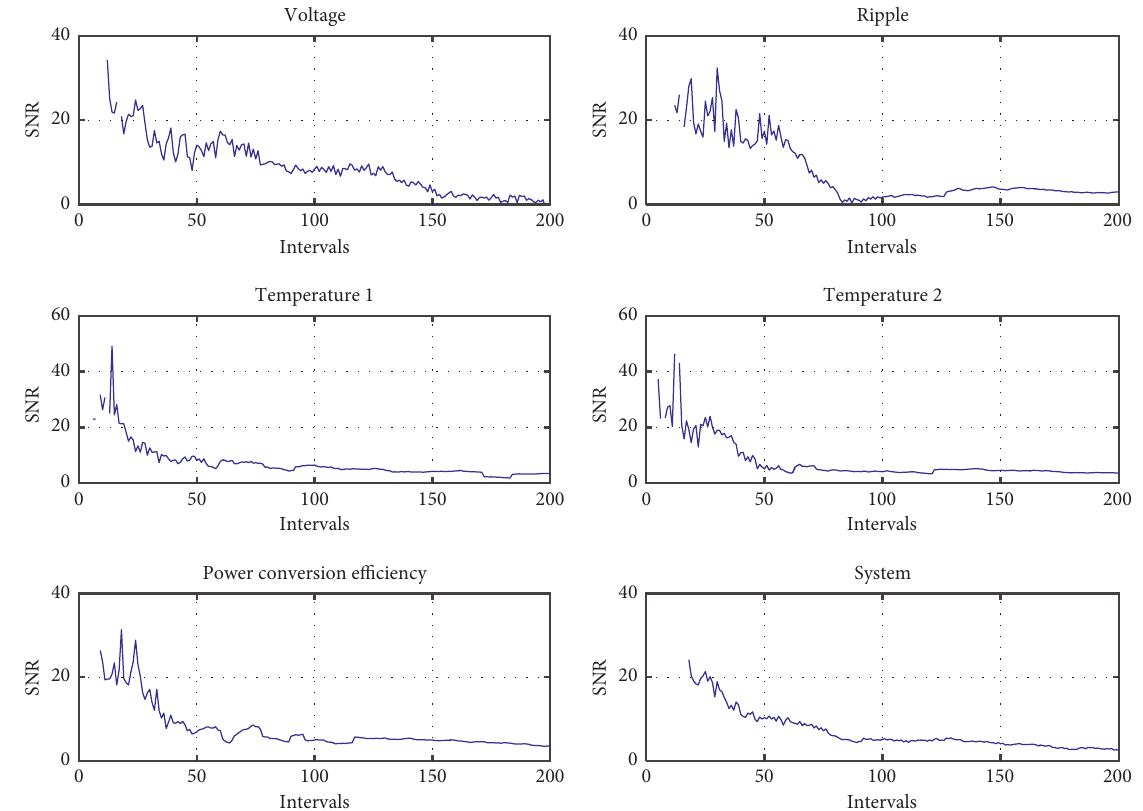
Figure 12: The power source key characteristic parameters and the system comprehensive signal-to-noise ratio